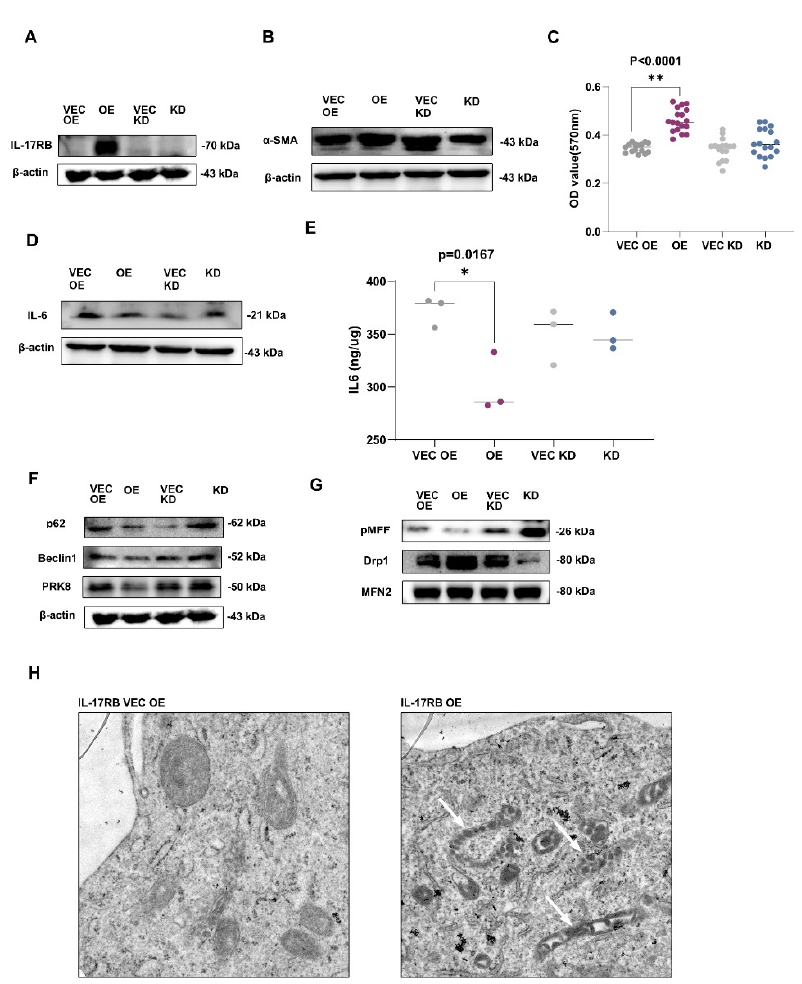
Figure 2. IL-17RB alters mitochondrial turnover and IL-6 secretion. ( A ) IL-17RB OE PSCs stably express IL-17RB without activation. IL-17RB KD PSCs do not express IL-17RB; ( B ) IL-17RB OE PSCs increase α -SMA. IL-17RB and α -SMA Western blot of IL-17RB OE and IL-17KD cells with corresponding control of IL-17RB VEC OE and IL-17RB VEC KD cells; ( C ) IL-17RB overexpression increases PSCs proliferation. MTT assay comparing IL-17RB OE, IL-17RB KD PSCs with respective controls (IL-17RB VEC OE and VEC KD, p < 0.0001, Mann–Whitney U test). Data represent the mean of three independent experiments conducted in sextuplicate; ( D ) IL-17RB overexpression decreases IL-6 expression. IL-6 Western blot of IL-17RB OE and IL-17KD PSCs with corresponding controls; ( E ) IL-17RB overexpression decreases IL-6 secretion, while IL-17RB knockdown induces no changes. ELISA of cell culture supernatant ( n = 3, OE vs. VEC OE, p = 0.0167, Mann-Whitney U test); ( F ) Auto-/mitophagy Western blot of IL-17RB OE and IL-17KD PSCs with corresponding controls. p62—Autophagy receptor p62, PRK8—Ubiquitin E3 ligase Parkin; ( G ) IL-17RB overexpression reduces mitochondrial fission and fragmentation. Western blot of IL-17RB OE and IL-17RB KD PSCs with corresponding controls. pMMF—phospho-mitochondrial fission factor, DRP1—phospho-Dynamin related protein 1; ( H ) IL-17RB overexpression induces elongated mitochondria with tubular cristae (white arrows). Electron microscope images of IL-17RB OE PSCs compared to IL-17RB VEC OE controls. Scale bar = 250 nm. * p < 0.05, ** p < 0.01.